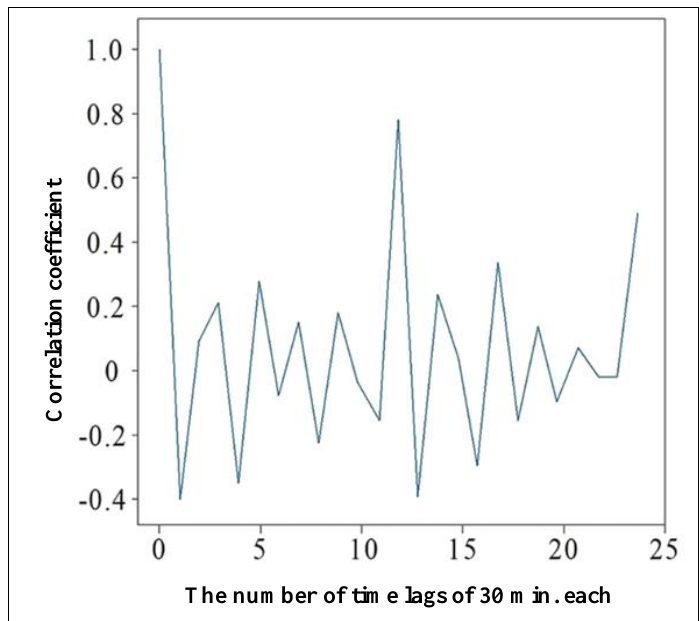
The number of time lags of 30 min. each Figure 4. Autocorrelation Function (ACF) of the ISR Time Series